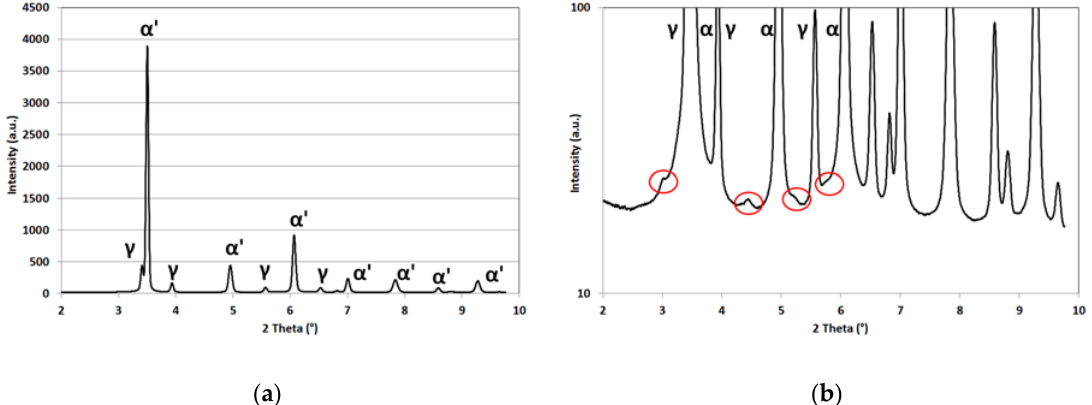
Figure 4. ( a ) 1D full scale diffractogram after circular integration of 2D Debye–Scherrer pattern (state 8 at room temperature after Q&P treatment). Major diffraction peaks are indexed and attributed to austenite ( γ ) and martensite ( α ’) respectively. ( b ) Enlargement of ( a ) (log scale) reveals the presence of minor diffraction peaks in between major peaks’ shoulders (red circles). These minor diffraction peaks are attributed to carbides.